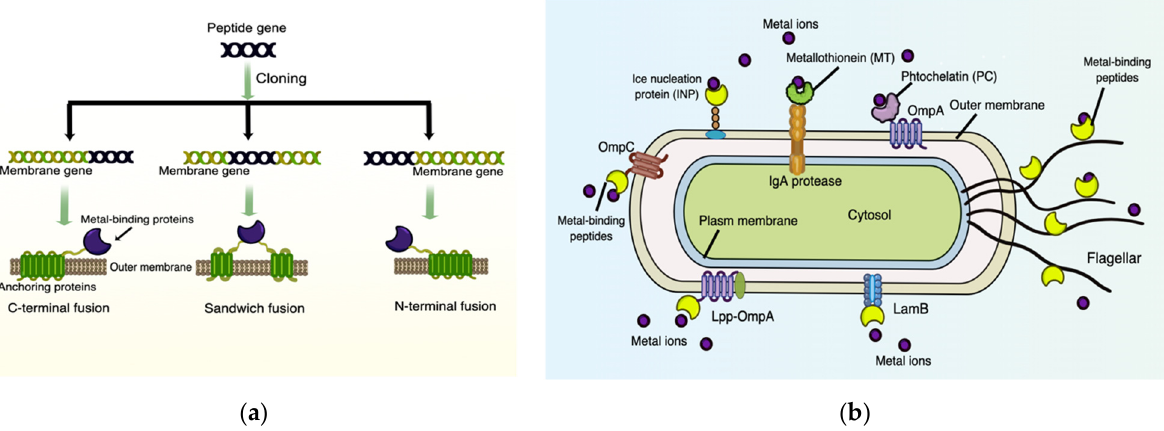
Figure 2. The procedure and principle of surface engineering towards metal adsorption in Gram- negative bacteria. ( a ) The coding DNA of target metal-binding peptides/proteins can be obtained from genome or plasmid DNA. After cloning it is transformed into the genome of host bacteria via fusion with the coding gene for an anchor protein (membrane protein) by one of the three different recombinant ways. Subsequently, by specific induction, the recombinant gene undergoes transcrip- tion, translation, and translocation into the cell surface. Based on different genetic recombinations, the target metal-binding peptide can be immobilized with the anchoring protein in the cell surface by C-terminal fusion, sandwich fusion or N-terminal fusion; ( b ) commonly used surface display systems in Gram-negative bacteria are described as follows: outer membrane proteins (OMPs): OmpA, OmpC, LamB, Ice nucleation protein (INP) and Lpp-OmpA; autotransporter: IgA protease; flagella. By these surface display systems, various metal-binding proteins/peptides can be anchored onto the outer membrane to adsorb specific metal ions. Metallothionein (MT) and phytochelatin (PC) are the most investigated metal-binding peptides that have been anchored to IgA protease [86] and OmpA [85], respectively. By Figdraw(www.figdraw.com accessed on 3 Arpil 2022).